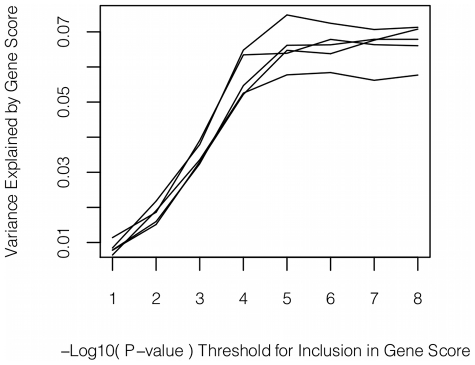
Polygene analysis.Variance explained (adjusted R2) by gene scores using varying P-value thresholds for inclusion of SNPs. Each P-value threshold was tested 5 times using a 5-fold cross-validation procedure.